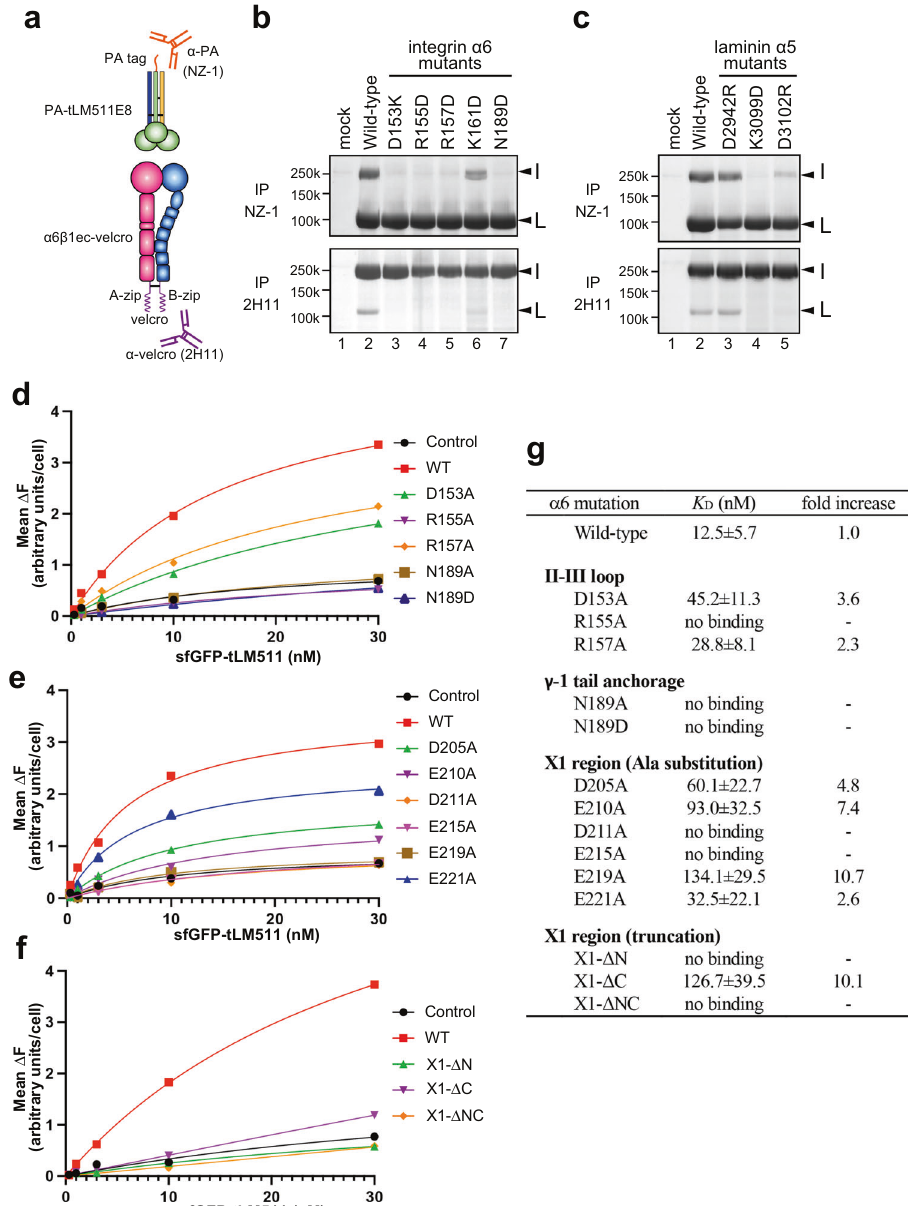
Fig. 6 Mutagenesis of the interface residues. a Schematics of the α 6 β 1 integrin ectodomain ( α 6 β 1ec-velcro) and tLM511 (PA-tLM511) constructs used for the pull-down binding assay. Binding of integrin mutants to wild-type laminin b and laminin mutants to wild-type integrin c . Each construct was transfected into Expi293F cells, and culture media of each pair of integrin/laminin were mixed and subjected to immunoprecipitation using anti-PA tag antibody (NZ-1, upper panel) or anti-velcro tag antibody (2H11, lower panel), followed by SDS-PAGE analysis under non-reducing condition. Band positions of α 6 β 1ec- velcro and PA-tLM511 are indicated by I and L, respectively. Immunoprecipitation experiments were repeated twice. Binding analysis of sfGFP-fused tLM511 to the integrin mutants expressed on the cell surface. Expi293F cells transiently expressing α 6 β 1 integrins with the II-III loop mutations d , X1-region mutations e , and loop truncation mutations f were incubated with increasing concentrations of sfGFP-tLM511 to measure its binding as described in the “ Method ” section. Each panel shows data from a representative experiment out of three independent ones. g Laminin binding af fi nity of mutant α 6 β 1 integrins. Equilibrium dissociation constants ( K D ) derived from the binding isotherms like the ones shown in d – f by non-linear regression analysis are shown. When the binding was below the level of control non-transfected cells (black circles in d – f ), that mutant integrin is judged as no binding. Data are mean ± SD of three independent experiments. Relative impact of each mutation on the binding is expressed as the fold-increase in the K D value from the wild-type. Uncropped gel images and source data are provided in the Source Data fi α 5 subunit in the construct described above, and the binding of the integrated fl uorescence values were plotted against the ligand resultant sfGFP-tLM511 to cells transiently expressing human concentration to derive equilibrium K D values (Fig. 6d, g). As the α 6 β 1 was evaluated by FACS. Concentration-dependent shift parent Expi293 cells express endogenous α 6 subunit at low level (Supplementary Fig. 7b), binding of sfGFP-tLM511 to Expi293 in the fl uorescence histogram was observed in the presence of (black lines in Fig. 6d – f) was regarded as a baseline. This 0.5 mM Mn 2 + (Supplementary Fig. 7a), and the net increase of